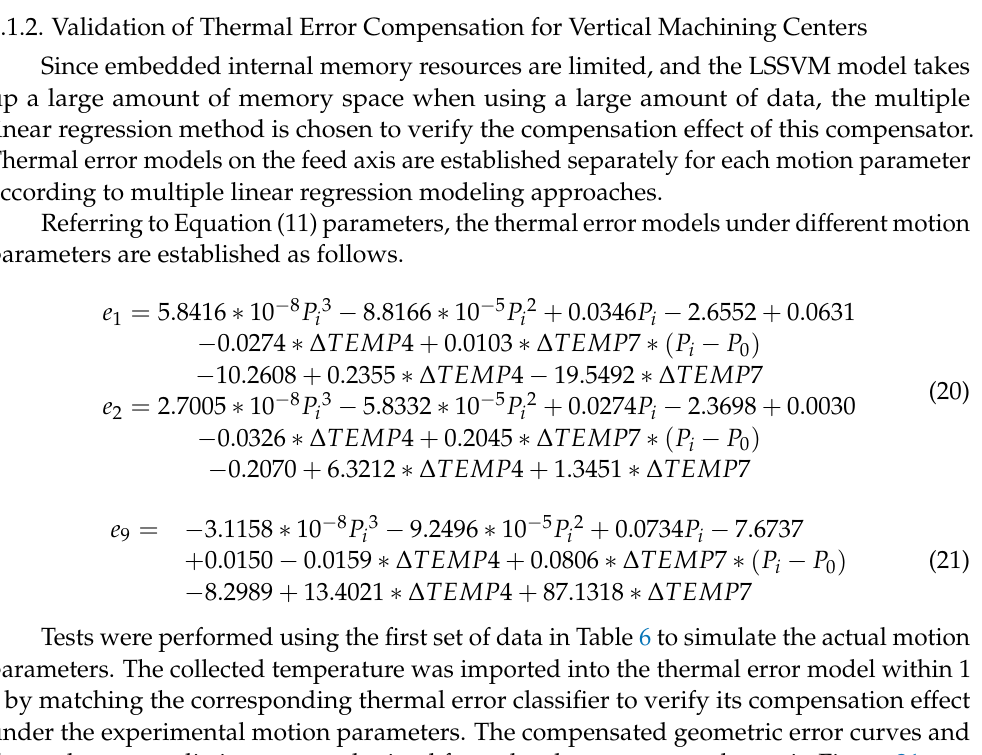
Table 7. Information sheet on thermal error test parameters. Test Parameters Working Stroke Air humidity [%RH] 75–80% RH Sampling interval [min] 30 min Overall measuring range [mm] 0–650 mm Machine warming state From complete cooling to thermal equilibrium Geometric error sampling feed rate [mm/min] 800 mm/min Laser interferometry sampling time [s] 2